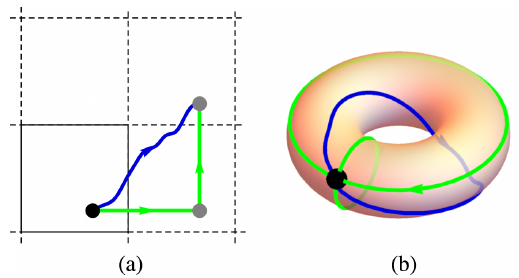
FIG. 1. (a) Two-dimensional atomic configuration space with periodic boundary conditions. (b) Representation of the ACS on a 2-torus. Open paths in the plane whose end points are one the periodic image of the other map onto closed paths in the torus; closed paths in the plane map onto trivial loops in the torus (i.e., closed paths that can be continuously shrunk to a point). The concatenation of the two green paths with the reversed blue one is a trivial loop on the torus. When strong adiabaticity holds, the total transported charge in a trivial path is